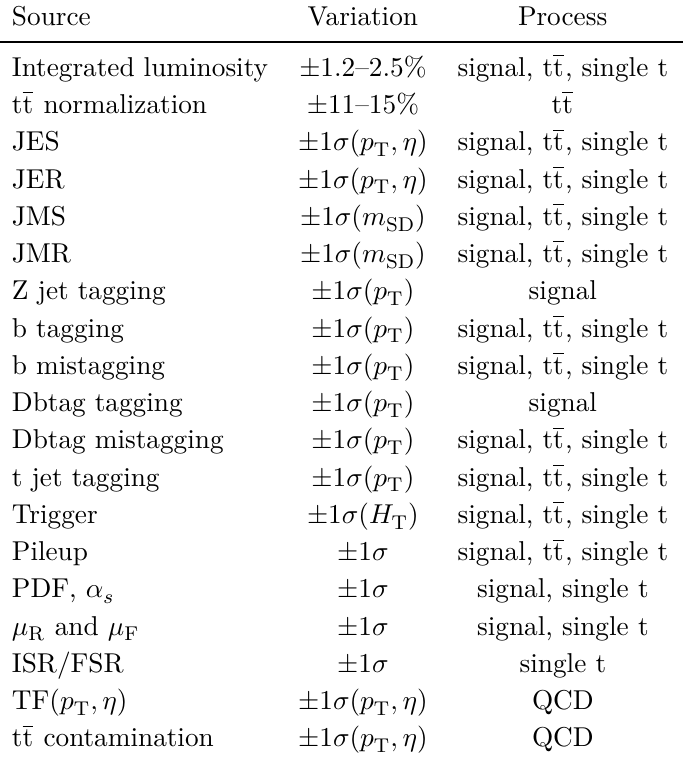
Table 3 . Sources of systematic uncertainty that affect the final distributions. Sources that affect the normalization only are represented by a range of values for the systematic variation. Sources listing the systematic variation as ± 1 σ ( x ) affect the shape of the three-jet invariant mass distribution as well, which is dependent on x